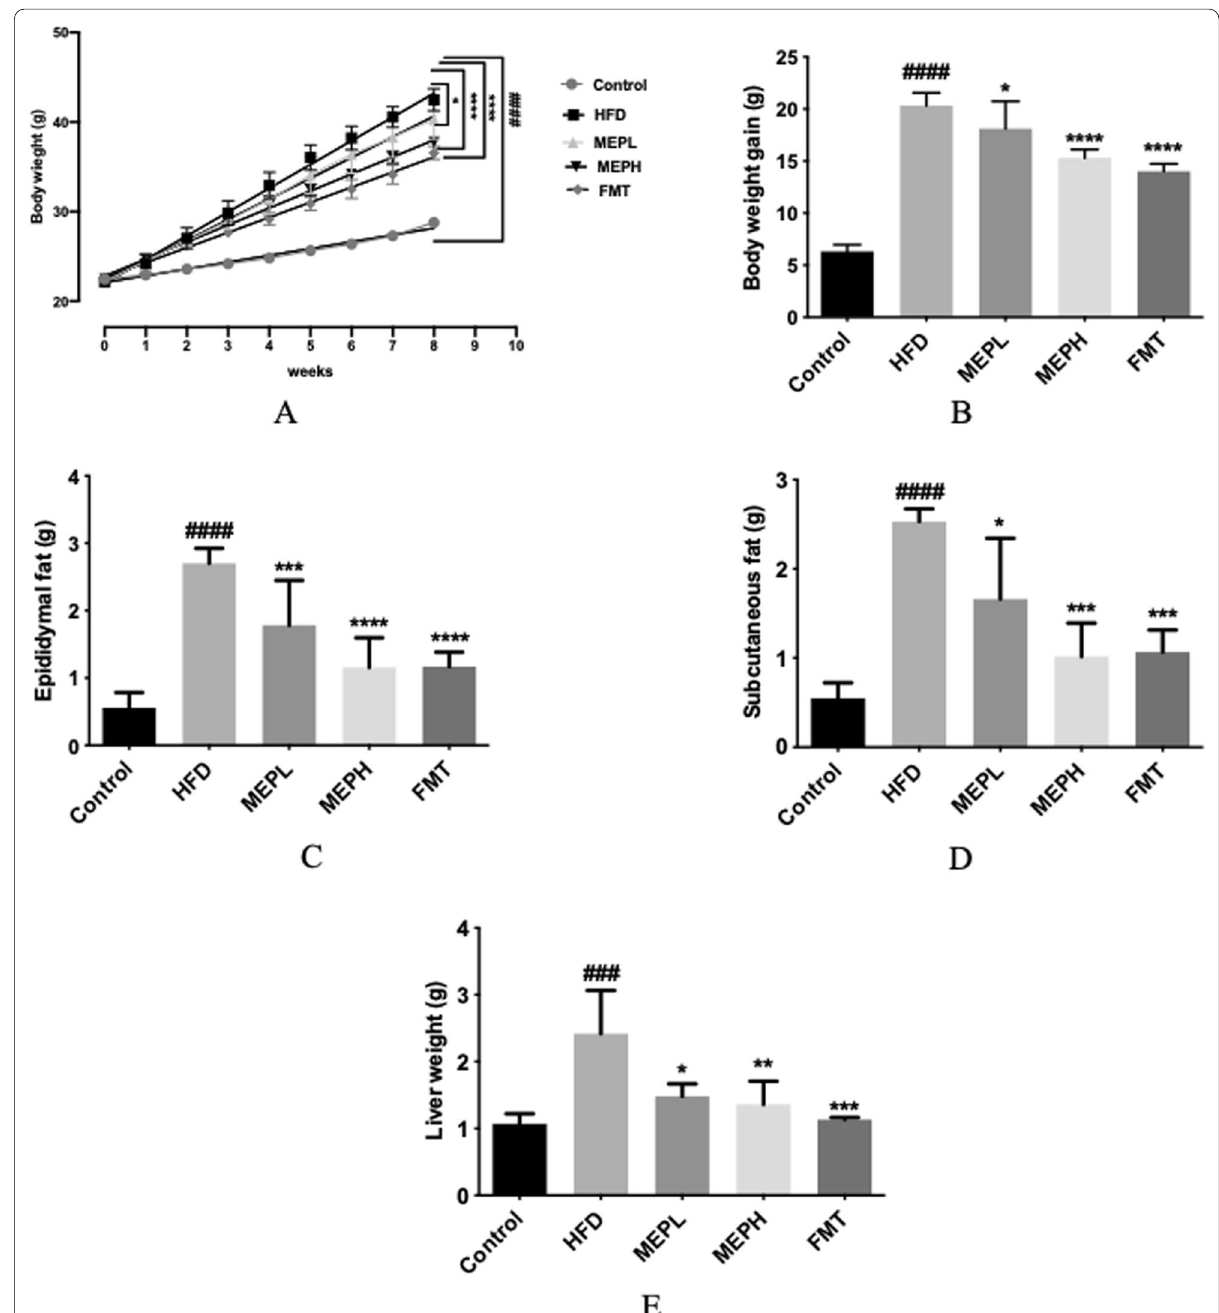
Fig. 2 Effect of MEP on body weight and fat deposition in HFD-induced obesogenic mice. A body weight (g) during 8 weeks treatment with MEP, B body weight gain in (%), C epididymal fat (g), D subcutaneous fat (g), and E liver weight (g), data expressed as mean one-way analysis of variance (ANOVA) with Tukey’s multiple comparison, significant differences were presented using # p < 0.05, ## p < 0.01 and ### p < 0.001 # ### p < 0.0001 vs. Control group and *p < 0.05, **p < 0.01and ***p < 0.001 ****p < 0.0001 vs. HFD